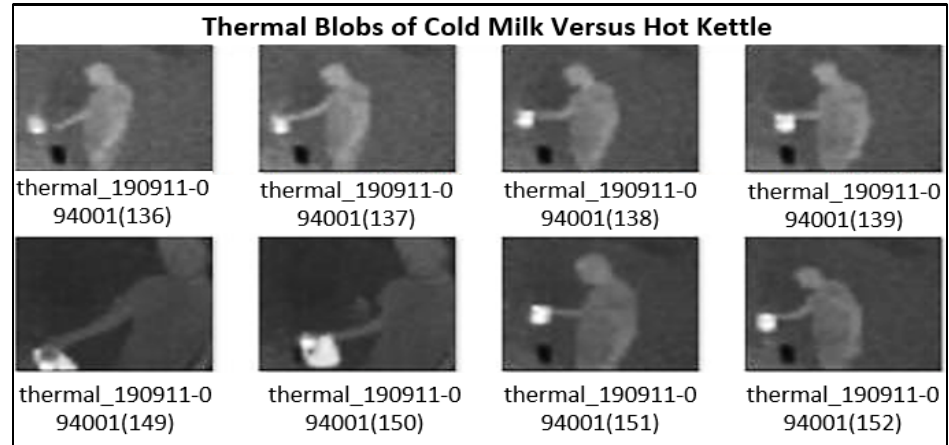
Figure 3. Thermal blobs of a bottle of cold milk (shades of black) distinguishable from a hot kettle (shades of white).